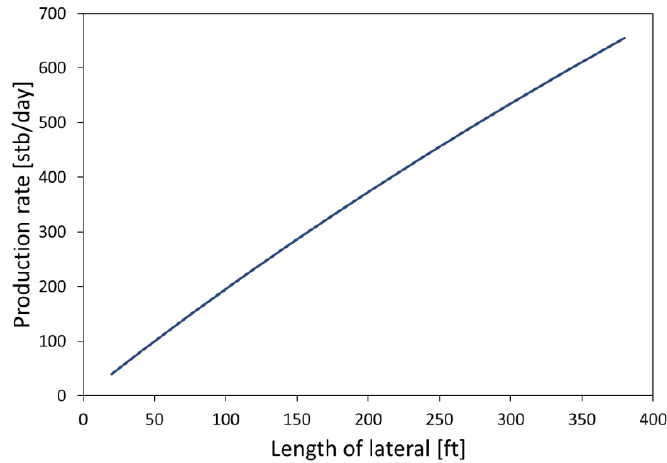
ff ect of lateral length on well production rate (Well #1). Figure 11. Modeled effect of lateral length on well production rate (Well #1). Figure 11. Modeled e